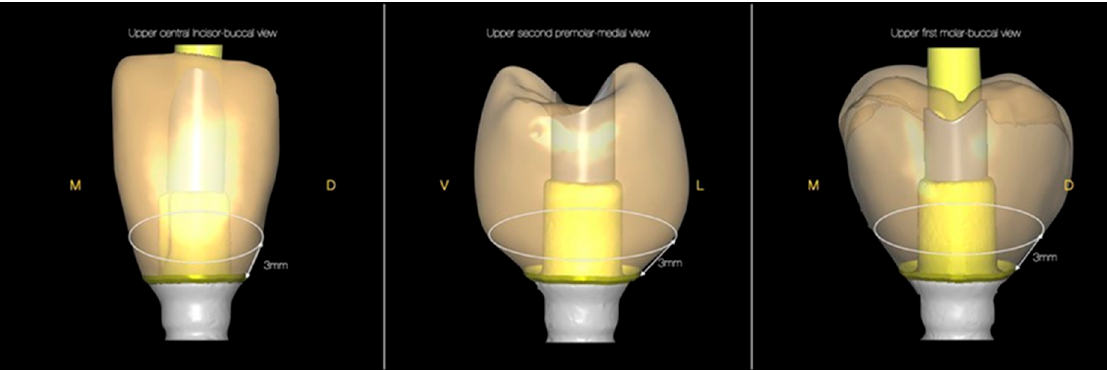
to analyze the volume and thickness of the ceramic material around the compared standard titanium base abutment (Figures 5 and 6).